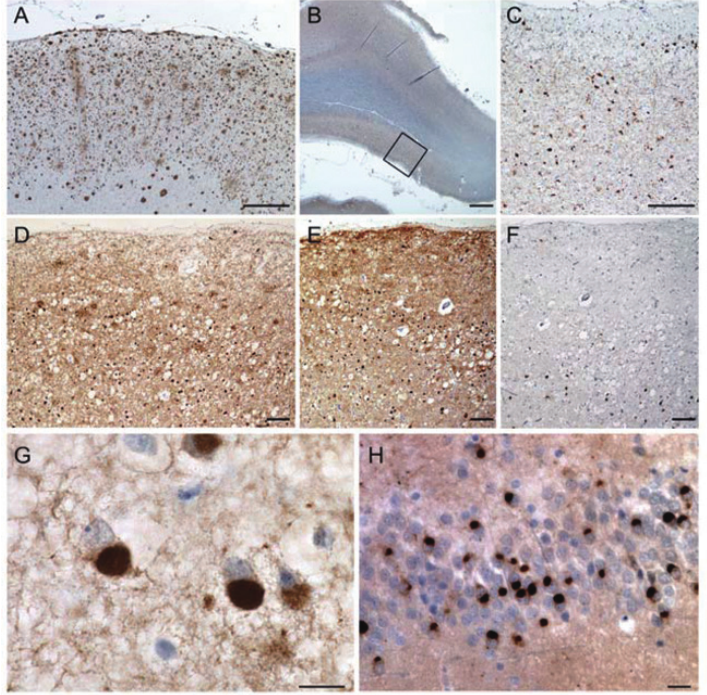
Fig. 3. Neuropathology. (A) Frequent diffuse and neuritic plaques, as well as moderate amyloid angiopathy, were seen in middle frontal gyrus and other neocortical regions using immunohistochemistry for amyloid-beta peptide. (B) Low magni fi cation image of the precentral gyrus (extending into frontal operculum) reveals severe cortical thinning and abundant cortical tau pathology (CP-13 antibody to phosphorylated tau). (C) Magni fi ed image of box in (B) reveals end-stage Pick’s disease, with massive neuronal loss, dense neuropil threads, and scattered dystrophic astrocytes. (D) In mid-insula, a non-speci fi c antibody to phosphorylated tau (CP-13) demonstrates Pick bodies and neuropil threads, as well as scattered neuritic plaques and neuro fi brillary tangles. Immunohistochemistry to phosphorylated 3R (E) and 4R (F) tau con fi rms a predominantly 3R tauopathy, with only AD-related deep layer neuro fi brillary tangles staining positively for 4-R tau. (G, H) Classical Pick bodies in mid-insula (G) and dentate gyrus (H) were identi fi ed with 3-R tau immunohistochemistry (G, H) but not with a 4-R tau antibody or Gallyas silver staining (not shown). Scale bars = 500 μ M (A), 1 mm (B), 500 μ M (C), 100 μ M (D-F), 10 μ M (G), and 25 μ M